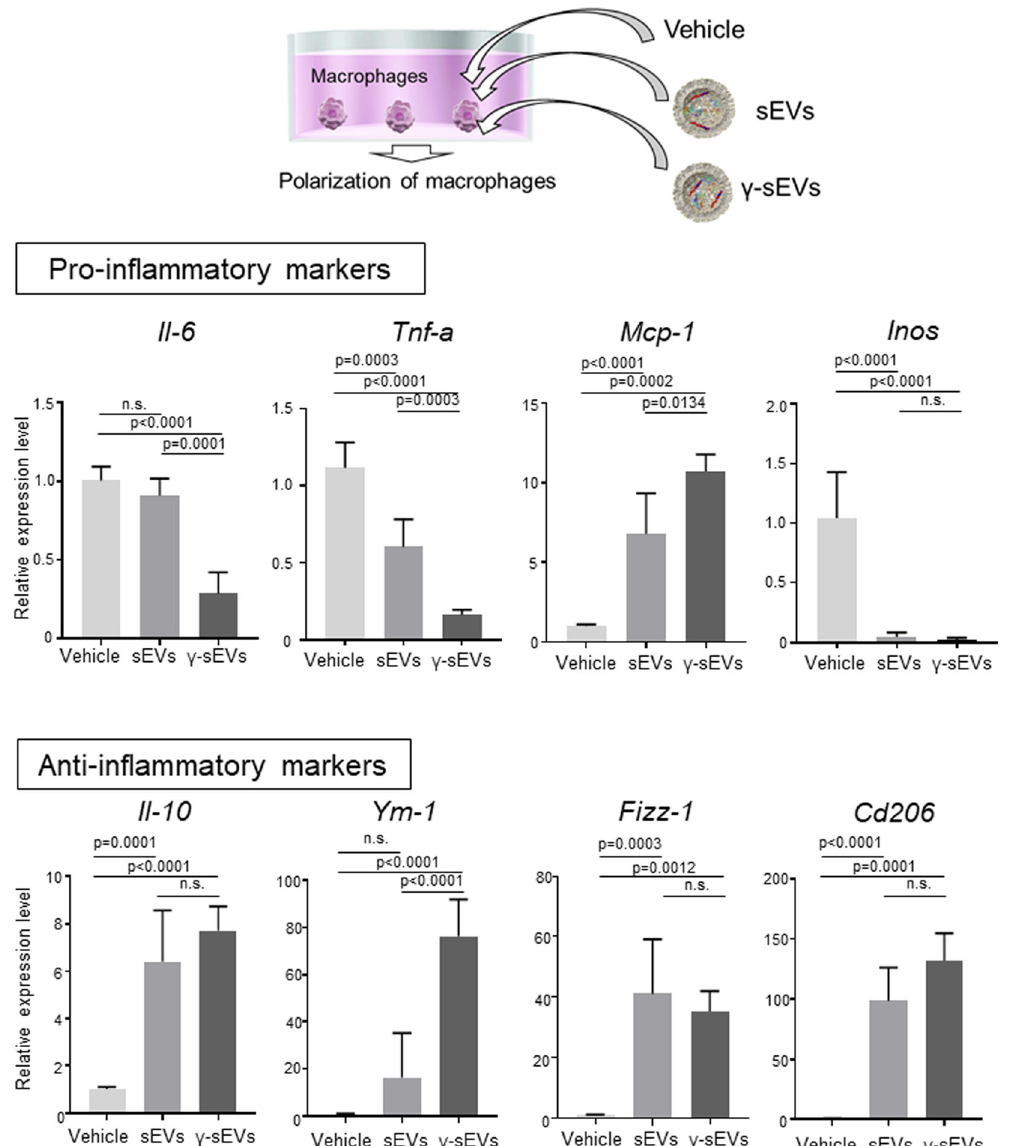
Fig. 1 Analysis of changes in macrophage polarity produced by AD-MSC-sEVs (sEVs) or AD-MSC- γ -sEVs ( γ -sEVs). Forty-eight hours after the addition of vehicle (PBS), sEVs, and γ -sEVs, macrophages were harvested and the mRNA expression levels of genes encoding pro- ( Il-6, Tnf- a, Mcp-1, Inos ) and anti- ( Il-10, Ym-1, Fizz-1, Cd206 ) in fl ammatory factors were evaluated using real-time PCR. Data are presented as means ± SD; n = 5 per